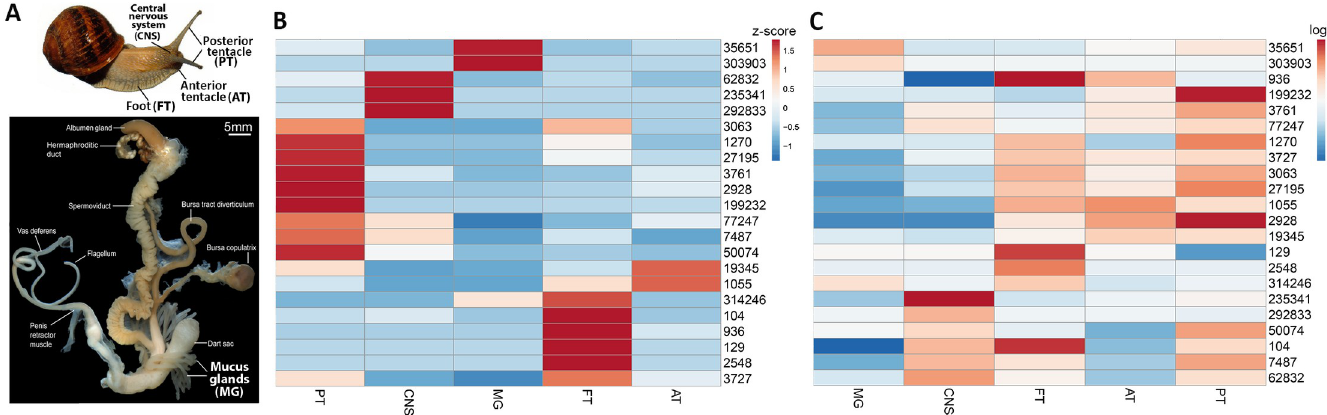
Fig 3. Relative gene expression of secreted proteins in Foot (FT), Mucous Gland (MG), Central Nervous System (CNS) and Posterior (PT) and Anterior Tentacles (AT) of C . aspersum . (A) Location of relevant snail tissues and abbreviations. (B) Relative gene expression based on z-score. Red indicates highest expression levels of gene as compared to other tissues. (C) Relative gene expression based on log2. Red indicates higher expression of gene as compared to other genes.